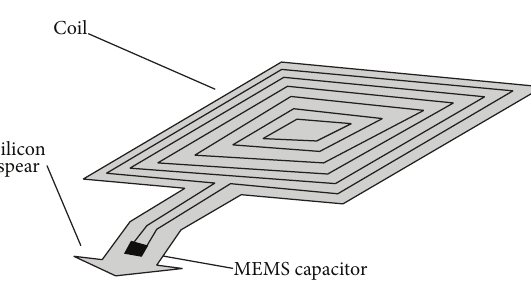
Figure 7: Implant geometry and